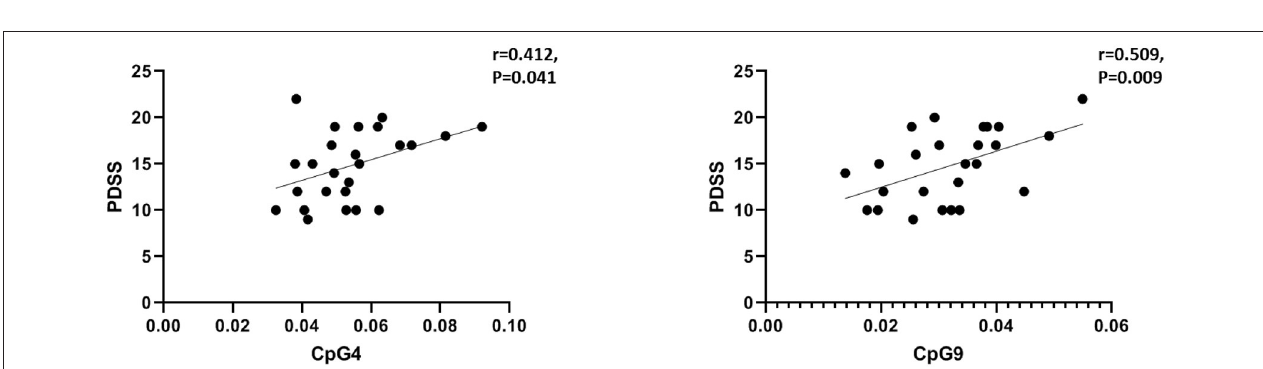
FIGURE 1 | Frequency of DNA methylation at 20 CpG sites located in the promoter region of the NOS1 gene in patients with panic disorder (PD) and in healthy controls (HCs). * p < 0.05.